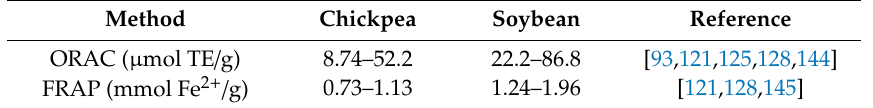
Table 4. Scavenging of peroxyl radical and reducing power of chickpea and